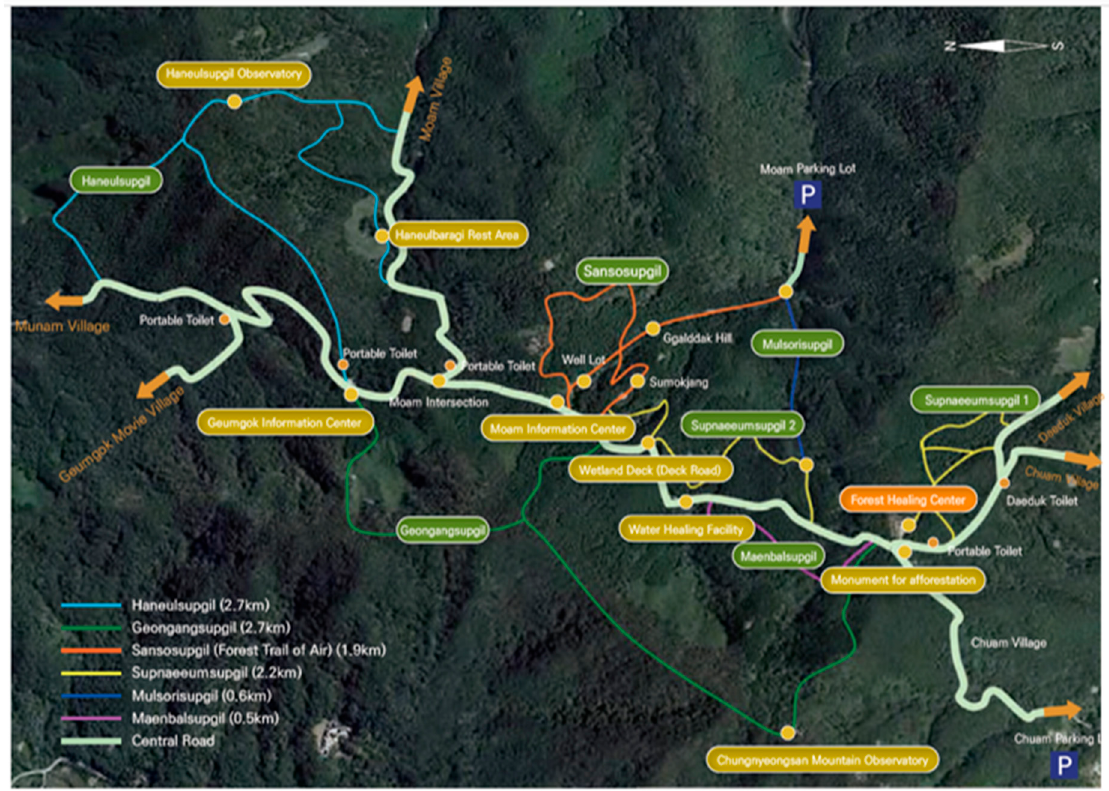
Figure 1. Jang-Seong forest healing area in Chungnyong mountain. It is about 37ha of the forest healing area in Jang-Seong. There is 10.8km forest healing trail. Walking program was provided by choosing an easy-to-walk trail.